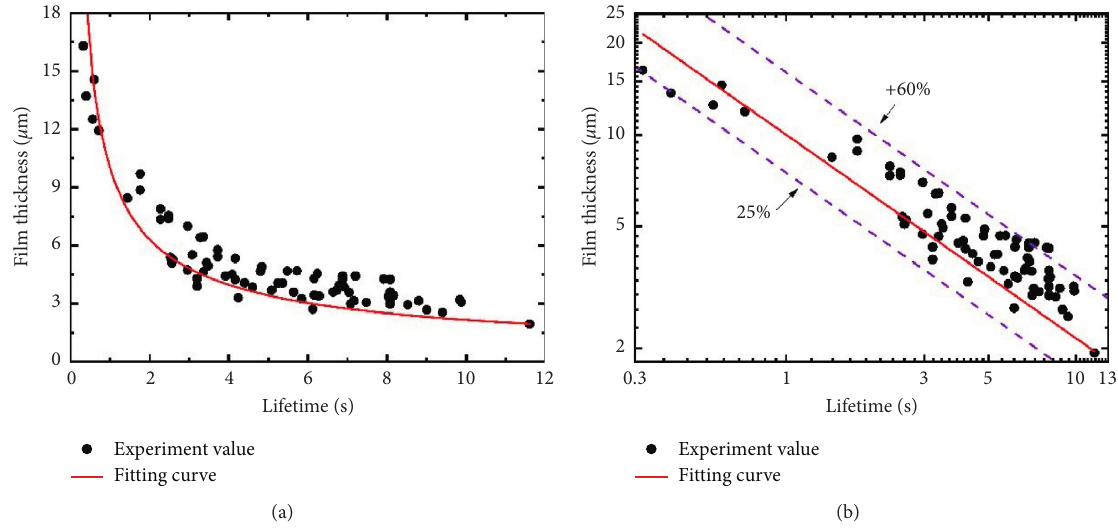
Figure 13: Correspondence of cap film thickness and bubble lifetime: (a) curve fitting and (b) error